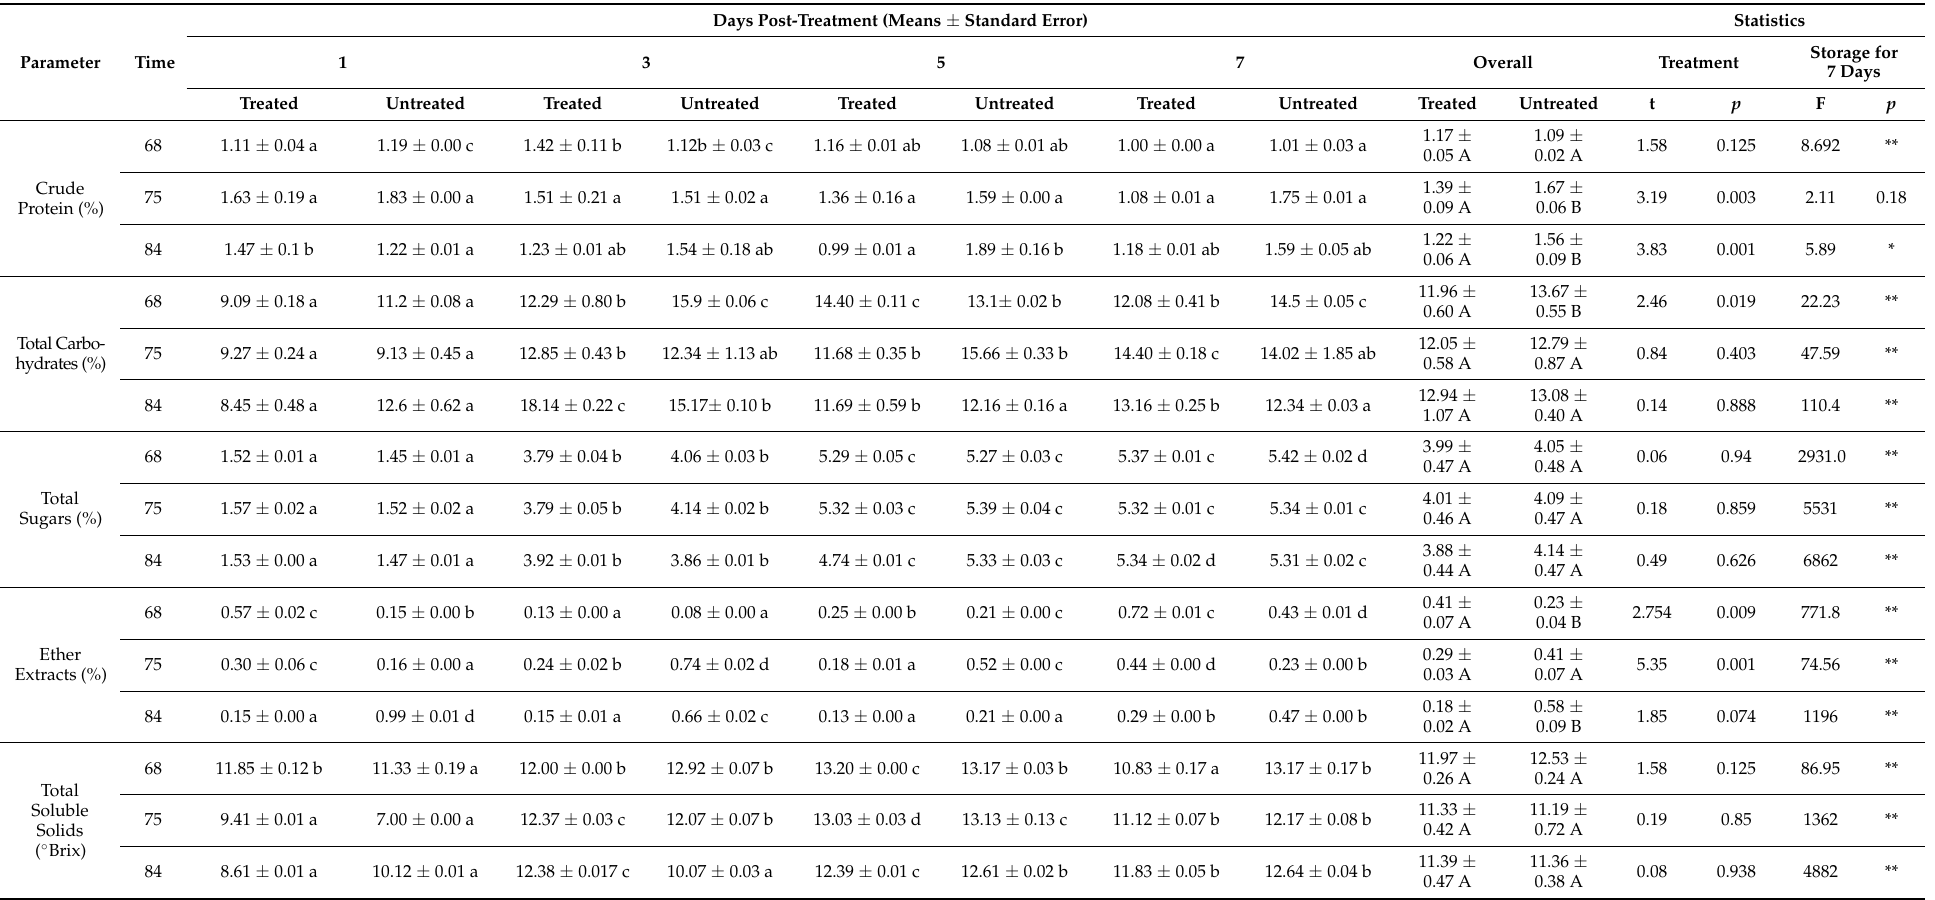
Table 5. Effect of hot water treatment at 46.1 ◦ C for different treatment durations on major macronutrients of Apple mango cultivar stored over 7 days